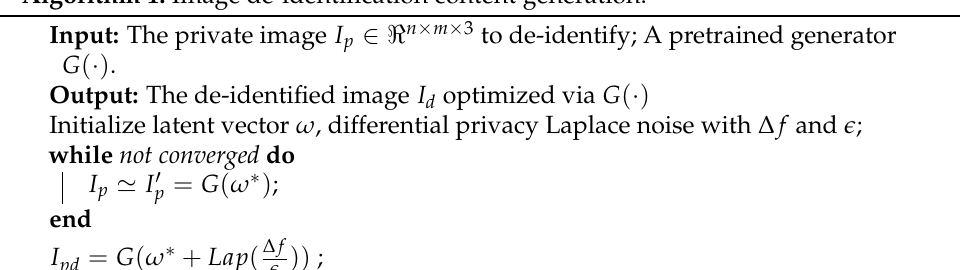
Algorithm 1: Image de-identification content generation.